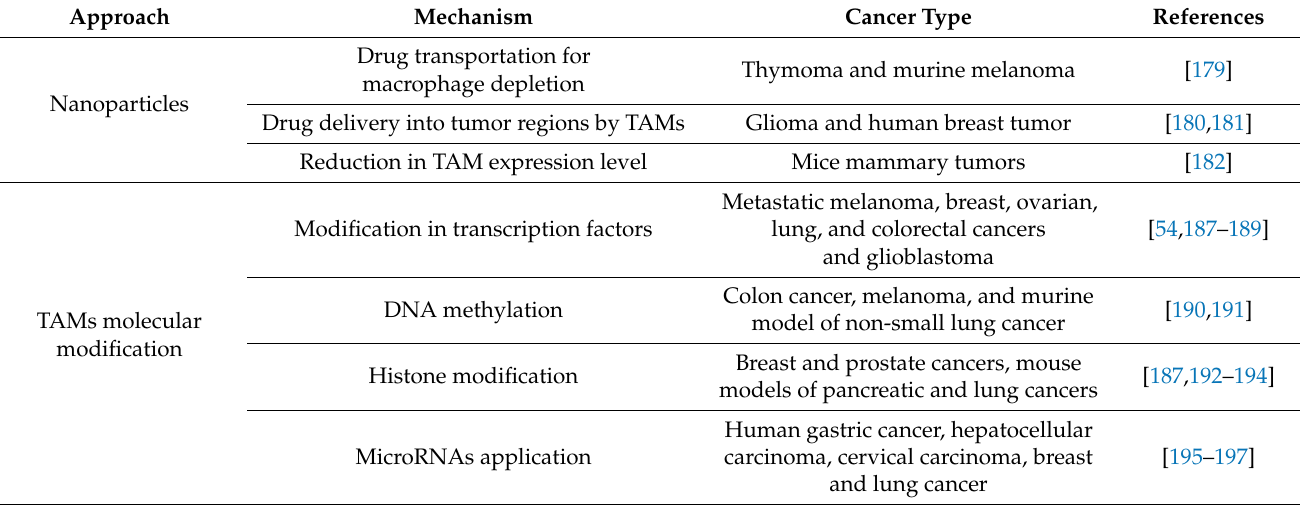
Table 2. Novel cancer therapy approaches developed based on TAM